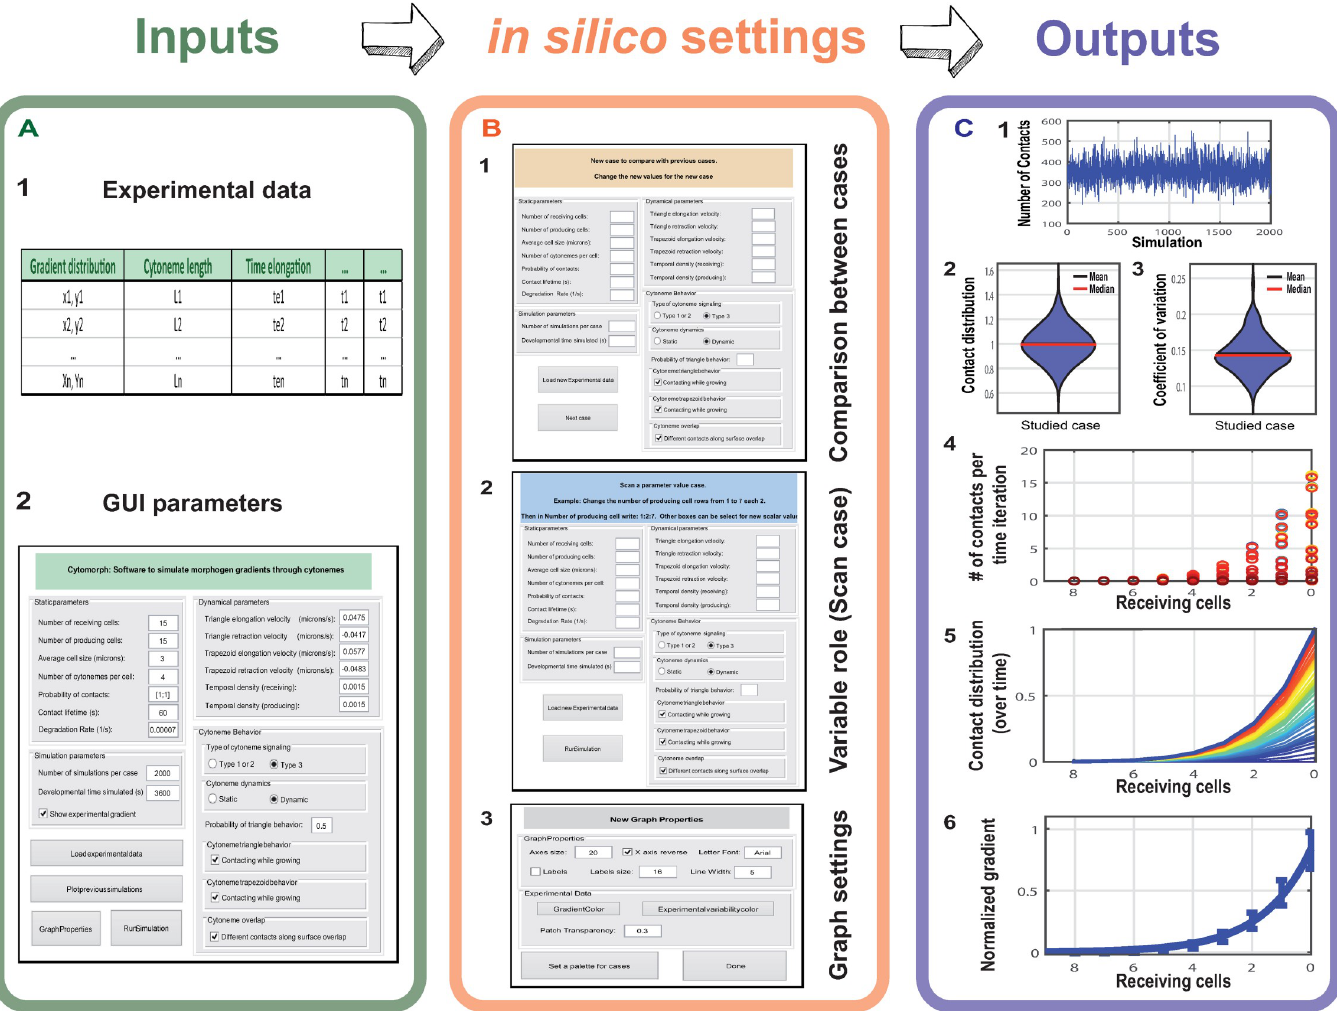
Fig 2. General outline of the Cytomorph workflow: ( A) Inputs of the Cytomorph, divided into two groups: A.1) Loading the data through an Excel table. A.2) Loading it through the main GUI. (B) Cytomorph secondary GUI windows: B.1) Window in which different parameter combinations (cases) can be loaded to compare with the reference case. B.2) Window in which a scan of variable values can be selected to study their effect. B.3) Window in which graphical properties can be selected. (C) Graphic outputs of Cytomorph simulations: C.1 and C.2) Contacts per cell along simulations. C.3) Signal variability measured by coefficient of variation. C.4) Contacts per cell and iteration. C.5) Temporal evolution of the contact distribution. C.6) Final gradient and expected variability (error bars).